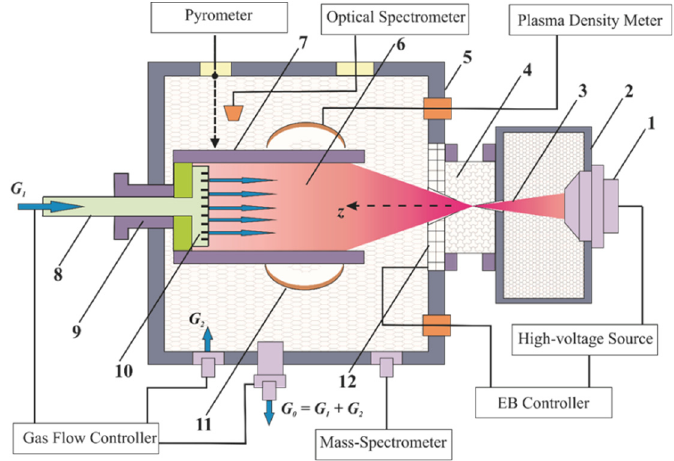
Figure 1. The scheme of the Electron-Beam Plasma Chemical Reactor: 1—electron-beam gun, 2—high-vacuum chamber, 3—electron beam (EB), 4—injection window, 5—working chamber, 6—EBP-cloud, 7—cylindrical reaction chamber, 8—gas feeder, 9—sealed bearing, 10—porous insert, 11–resonator, 12—scanning system; G 1 —main gas flow, G 2 —flow of gaseous additives, G 0 —gas evacuation efficiency, z -axis of the EB injection.